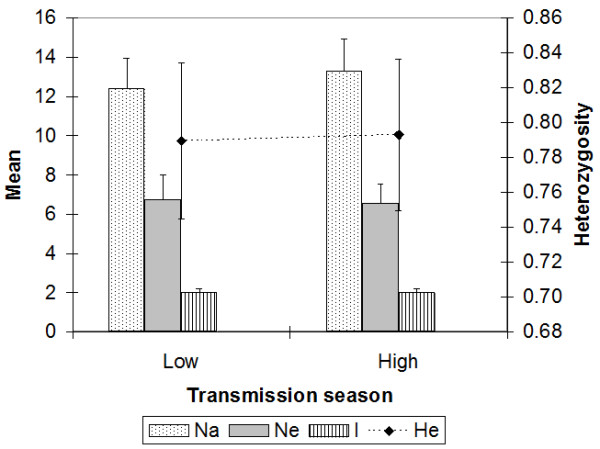
Microsatellite allelic patterns across transmission seasons. No significant difference in diversity was observed between the low and high malaria transmission seasons. Whiskers represent standard error values.